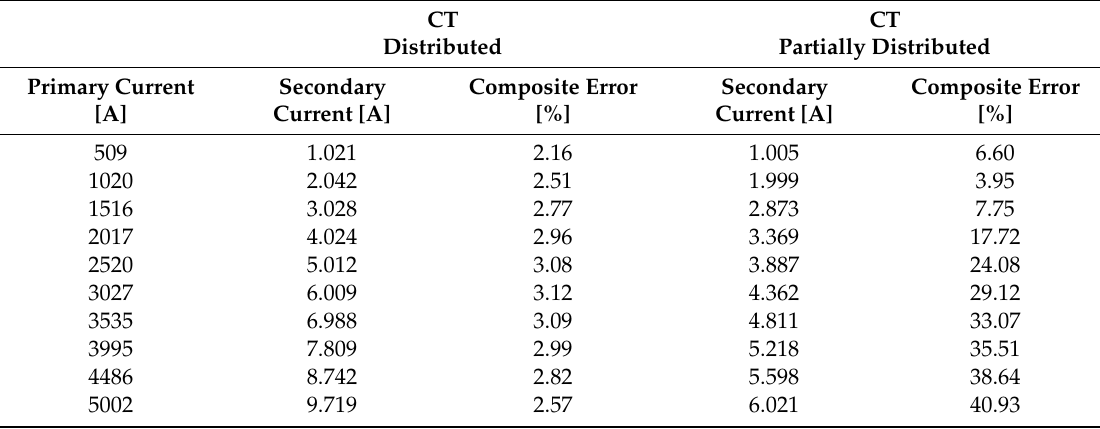
Table 3. Current transformers direct method experimental test